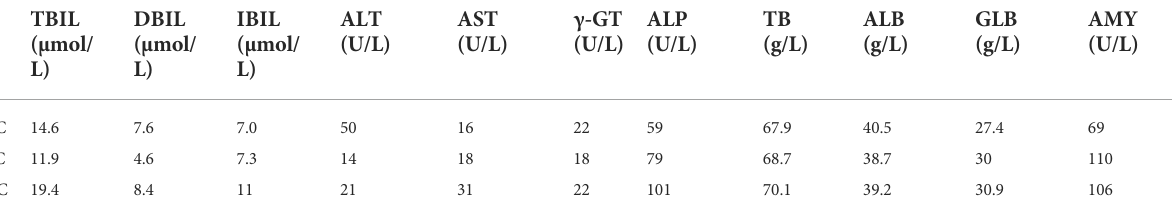
TABLE 3 Changes in liver function during neoadjuvant therapy cycles.